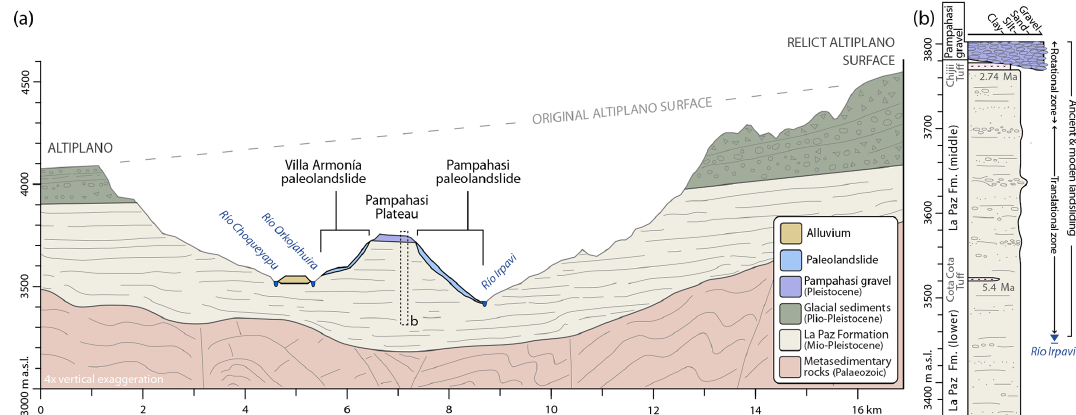
Figure 3. Stratigraphic sequence. (a) Cross-section oblique to the trend of the Cordillera Real through the fill underlying the Altiplano (location in Fig. 1b). (b) Lithostratigraphy beneath Pampahasi Plateau, including principle units involved in the Pampahasi paleolandslide and 2011 Pampahasi landslide. Modified from Anzoleaga et al. (1977) based on field mapping throughout the La Paz